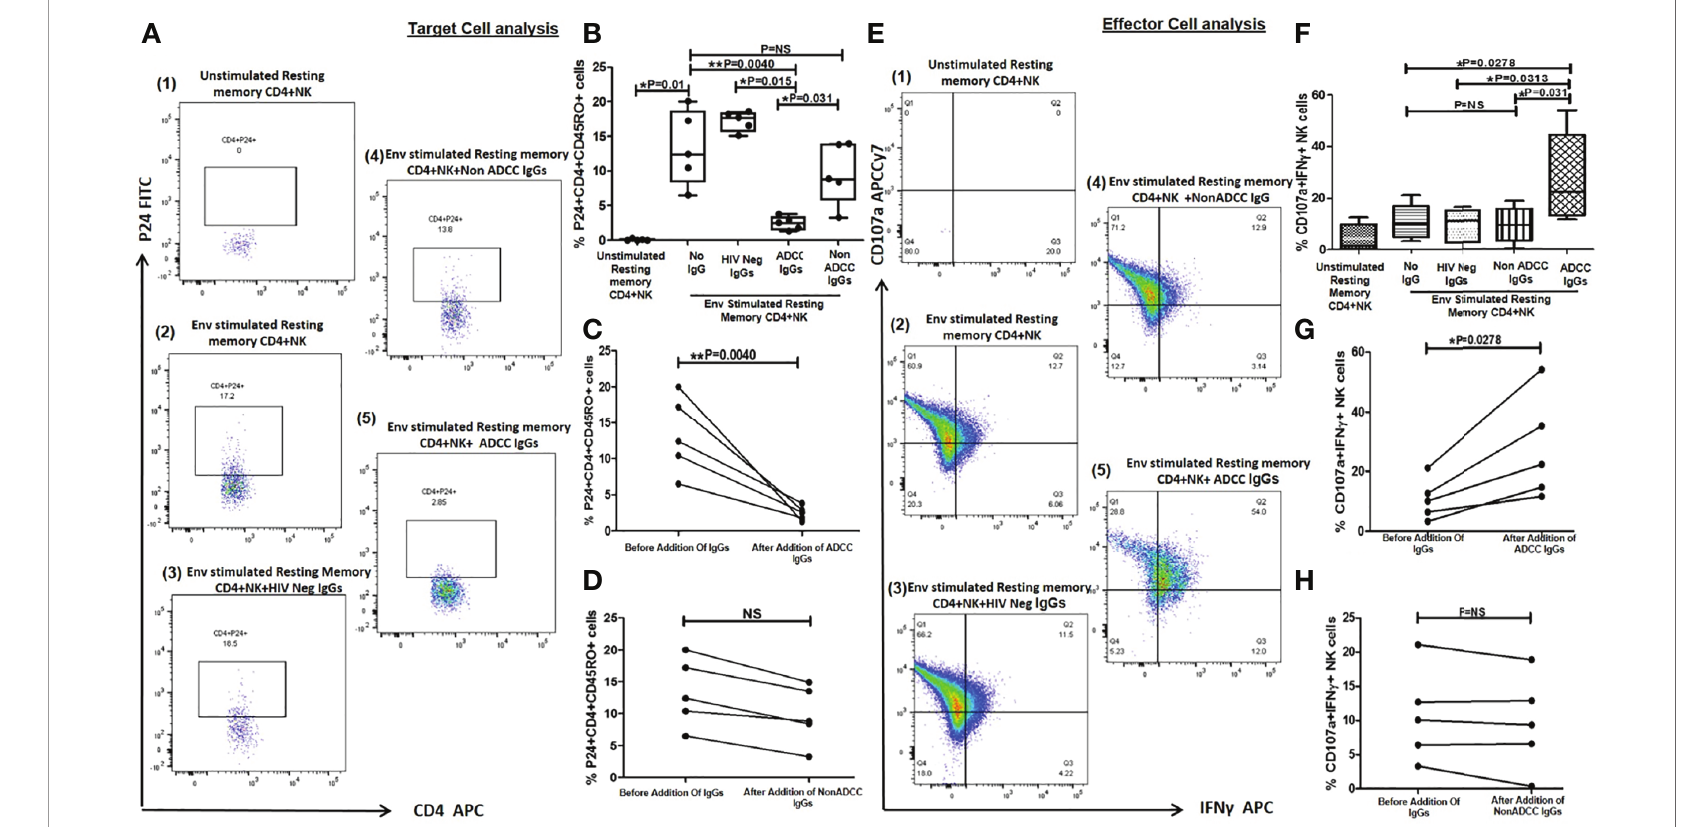
FIGURE 4 | Lysis of reactivated resting memory CD4+ cells from HIV infected patients by ADCC. (A) The Representative FACS dot plots shows % P24+CD45RO+CD4+ cells (resting memory CD4) (P24 on Y axis and CD4 on X axis) in (1) unstimulated resting memory CD4 cells with effector cells (NK cells) (2), after HIV ENV C stimulation (3), after addition of HIV Neg IgGs (4), after addition of NonADCC IgGs, and (5) after addition of ADCC IgGs. (B) The bar diagram shows the frequency of p24+CD45RO+CD4+ cells (on Y axis) before HIV ENV C stimulation, after HIV ENV C stimulation, after addition of HIV neg IgGs, ADCC IgGs and non-ADCCC IgGs (on X axis). The paired line graph shows % p24+CD4+CD45RO+ cells (on Y axis) before and after addition of (C) ADCC IgGs (P = 0.004), and (D) before and after addition of non-ADCC IgGs. The data was analyzed with Wilcoxon matched paired T test. (E) . The representative dot plots shows CD107a (on Y axis) and INF g (on X axis) secreting cells in (1) unstimulated resting memory CD4 cells with effector cells (NK cells) (2), after stimulation with Env C (3), after addition of HIV neg IgGs (4), after addition of non ADCC IgGs, and (5) after addition of ADCC IgGs. (F) The bar diagram shows percent CD107a and IFN g secreting NK cells (on Y axis) before HIV ENV C stimulation, after ENV stimulation, after addition HIV neg IgGs, non-ADCC IgGs, and ADCC IgGs (on X axis). The paired graphs (G) shows frequencies of CD107a+IFN g + NK cells (on Y axis) before and after addition of ADCC Abs (P = 0.0278) (Wilcoxon matched paired T test) and (H) before and after addition of non-ADCC IgGs. NS, not signi fi